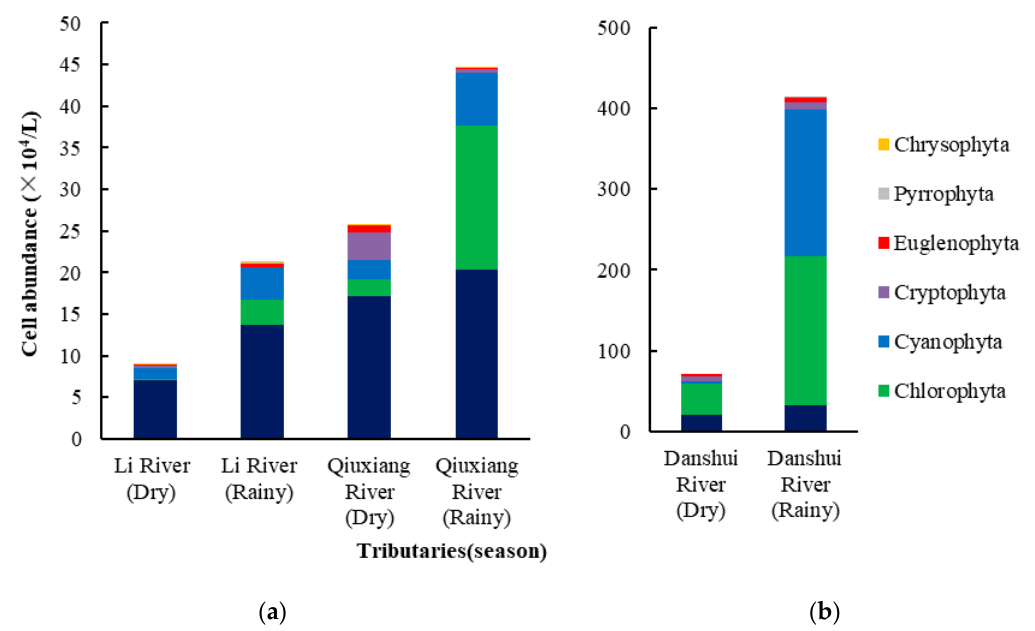
Figure 2. Cell abundance and phyla percentage of the phytoplankton community in three tributaries in the dry and rainy season. The cell abundance shown in the figure is the average of five samples. ( a ) lower cell abundance; ( b ) higher cell abundance.